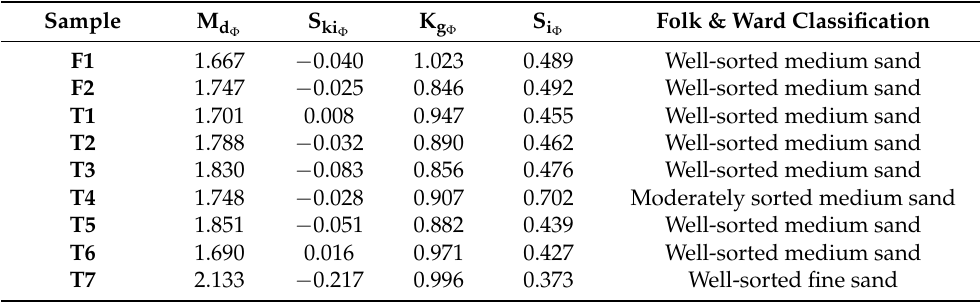
Table 2. Statistical parameters and classifications were obtained for samples F1, F2, T1, T2, T3, T4, T5, T6, and T7.